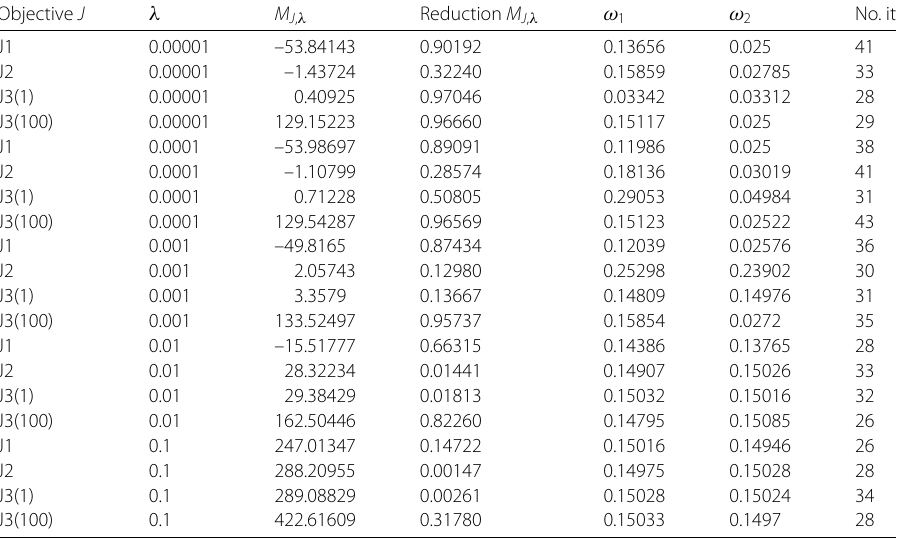
Table 4 Optimization of gas flow rates. Minimum objectives M J , λ and corresponding frequencies ω i , i ∈ { 1,2 } . The last column is the number of required optimization iterations. (cid:18) t = 0.05, mesh 3 Objective J